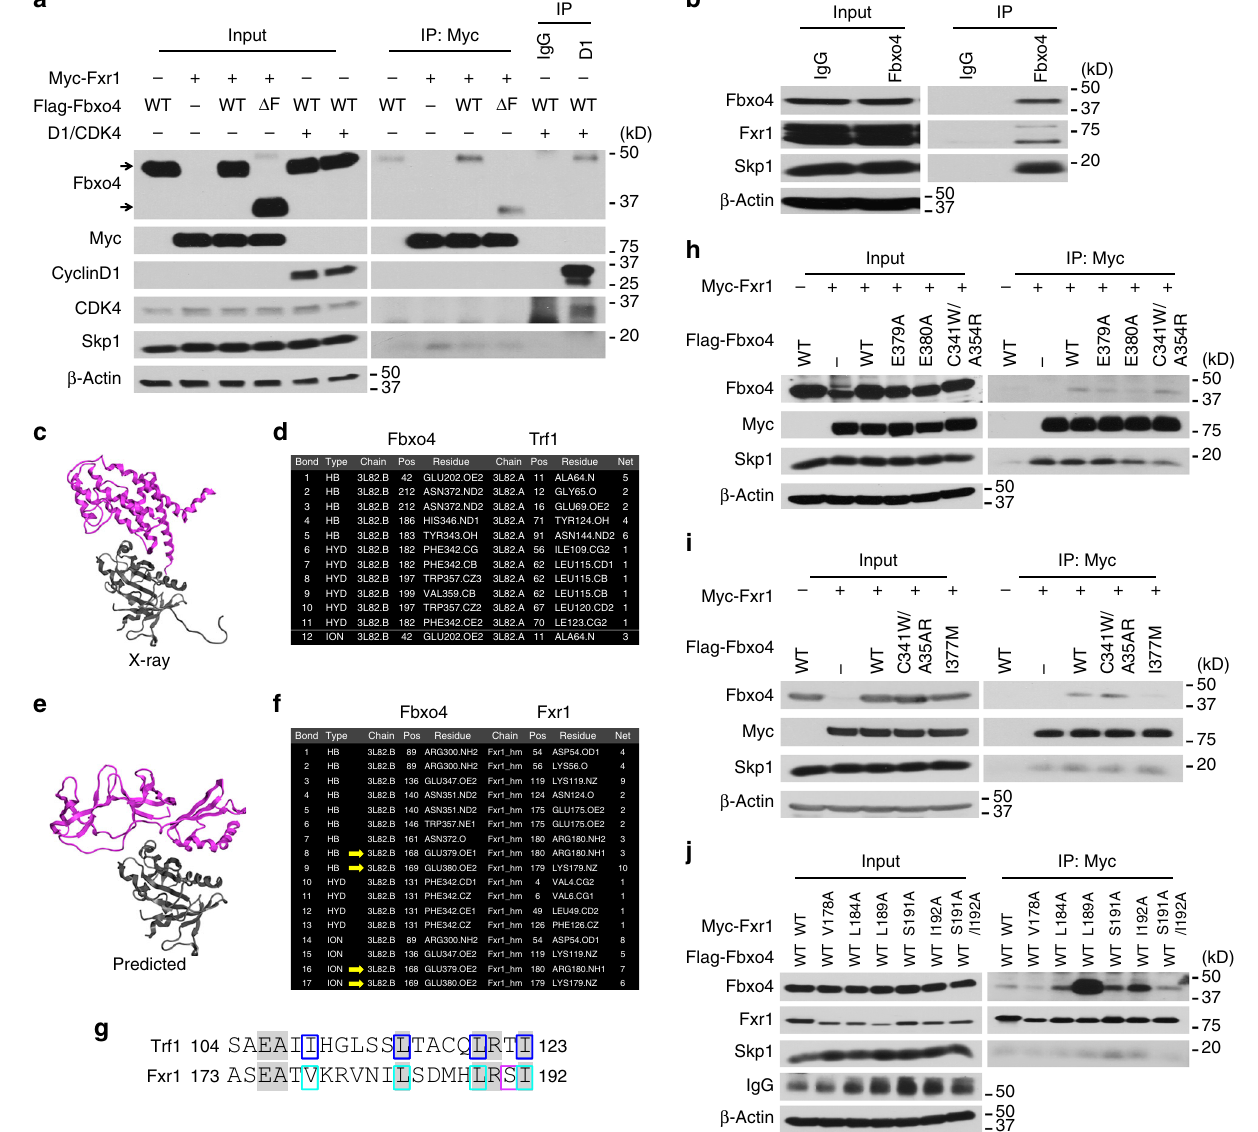
Fig. 1 Fbxo4 directly interacts with Fxr1. a Co-immunoprecipitation of Fbxo4 and Fxr1; arrows indicate Fbxo4 bands. b Endogenous Fbxo4 co-immunoprecipitates with Fxr1. c Ribbon diagram of the Fbxo4:Trf1 heterodimer, PDB:3L82. Fbxo4 is coloured in grey and Trf1 is in purple. d Intermolecular interactions between Fbxo4 and Trf1 derived from the PDB:3L82. e Ribbon diagram of the predicted interaction of Fbxo4 and an Fxr1 homology model. Fbxo4 is coloured in grey and Fxr1 is in purple. f Intermolecular interactions between Fbxo4 and Fxr1. HB is hydrogen bond, HYD is hydrophobic interaction, and ION an ionic bond. g Alignment of a semi-conserved motif in Trf1 and Fxr1. Identical amino acids are highlighted. Residues forming intermolecular bonds in Trf1 are boxed in blue, while residues mutated in this work are boxed in turquoise and magenta. Identity in this region was 30%, while similarity is 65%. h Fbxo4 E379A and E380A mutations disrupt the interaction between Fbxo4 and Fxr1. i Fbxo4 I377M mutation also disrupts the interaction between Fbxo4 and Fxr1. j Fxr1 V178A suppresses, while L189A Fxr1 enhances the interaction between Fbxo4 and